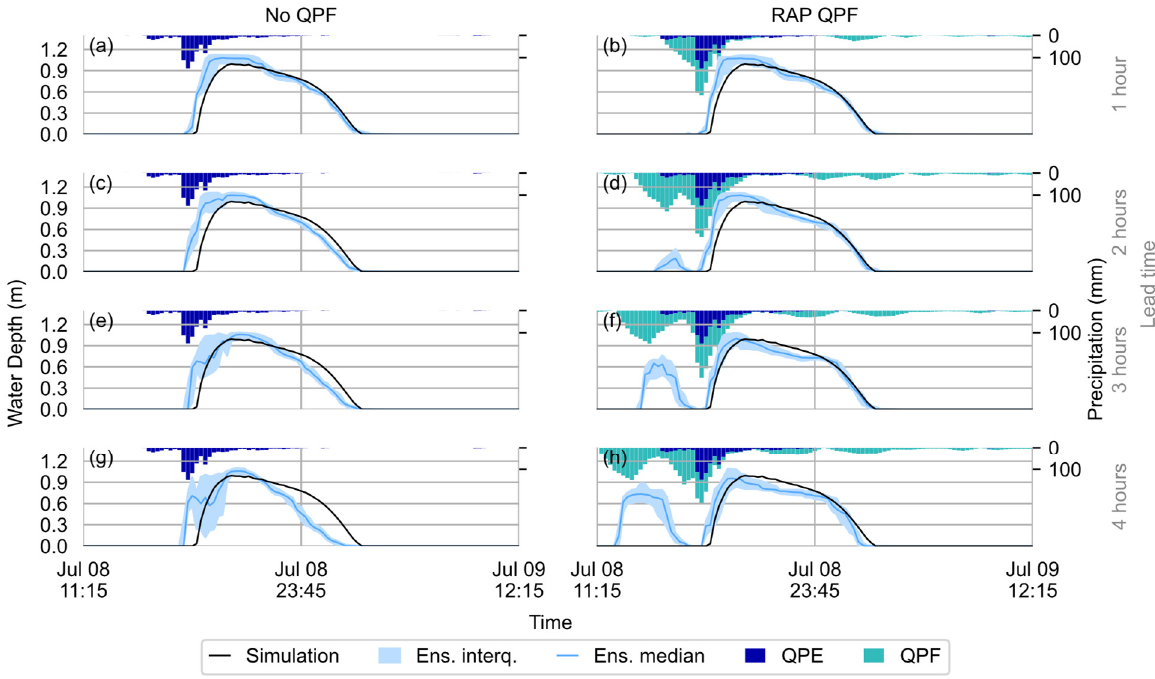
Figure 11. ( a – h ) Same as Figure 10, but for POI 2.